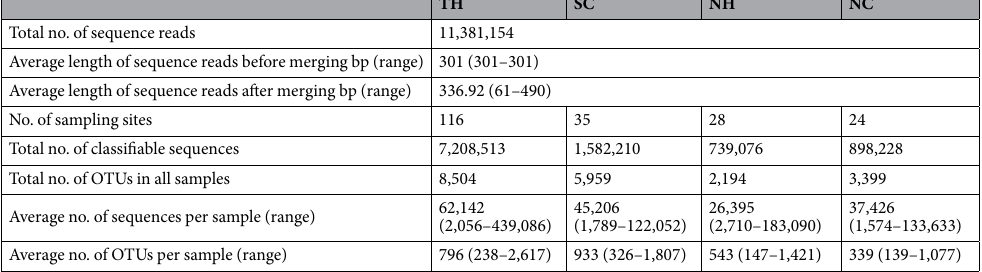
Table 2. Summary description of the sampling sites, the number of sequences collected, and the level of bacterial diversity identified. Phylotypes were determined at the 97% sequence similarity